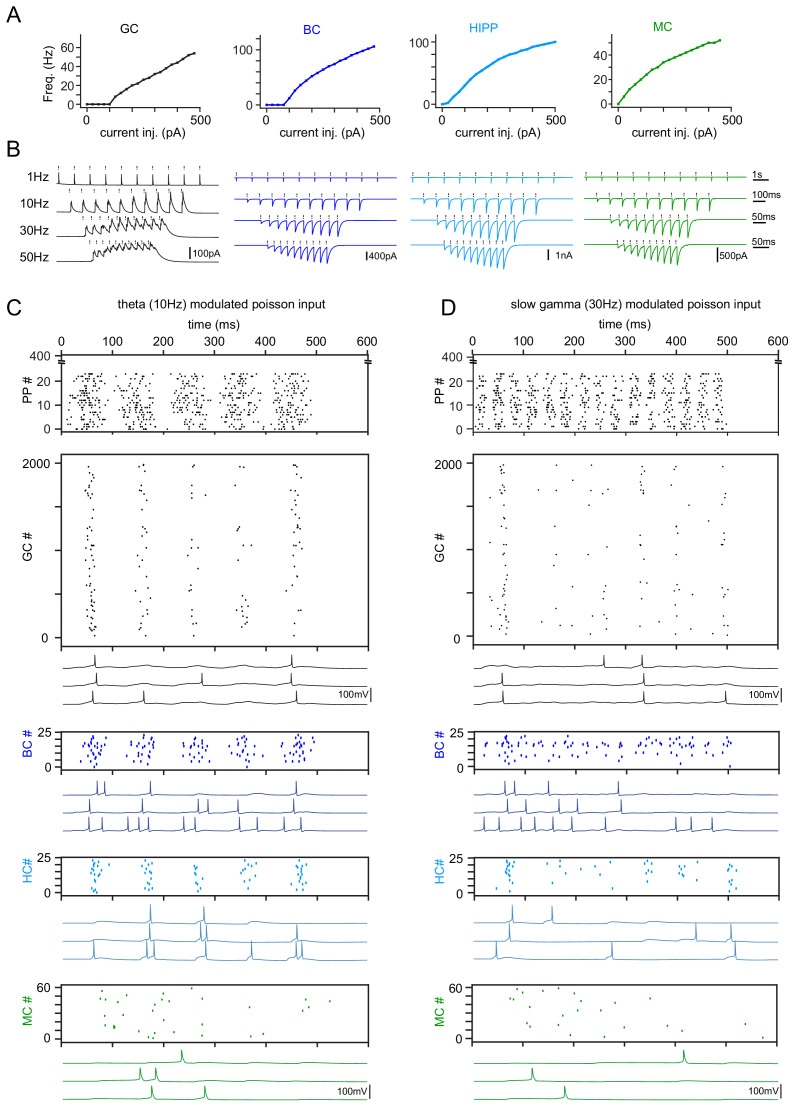
Model tuning and validation.(A) Frequency responses to somatic current injections of model cell types (GC: granule cells, BC: basket cells, HC: hilar perforant path associated cells, MC: mossy cells). All model cells were matched to data by Santhakumar et al. (2005). (B) Simulation of synchronous frequency stimulation of GCs and the resulting PSCs in modeled cell types, analogous to Figure 4. (C) Representative theta modulated PP input and population responses (scatterplots) of all modeled cell types. Following each scatterplot are three examples of spiking cells of the respective type. (D) Same as (C) but for slow gamma modulated inputs.